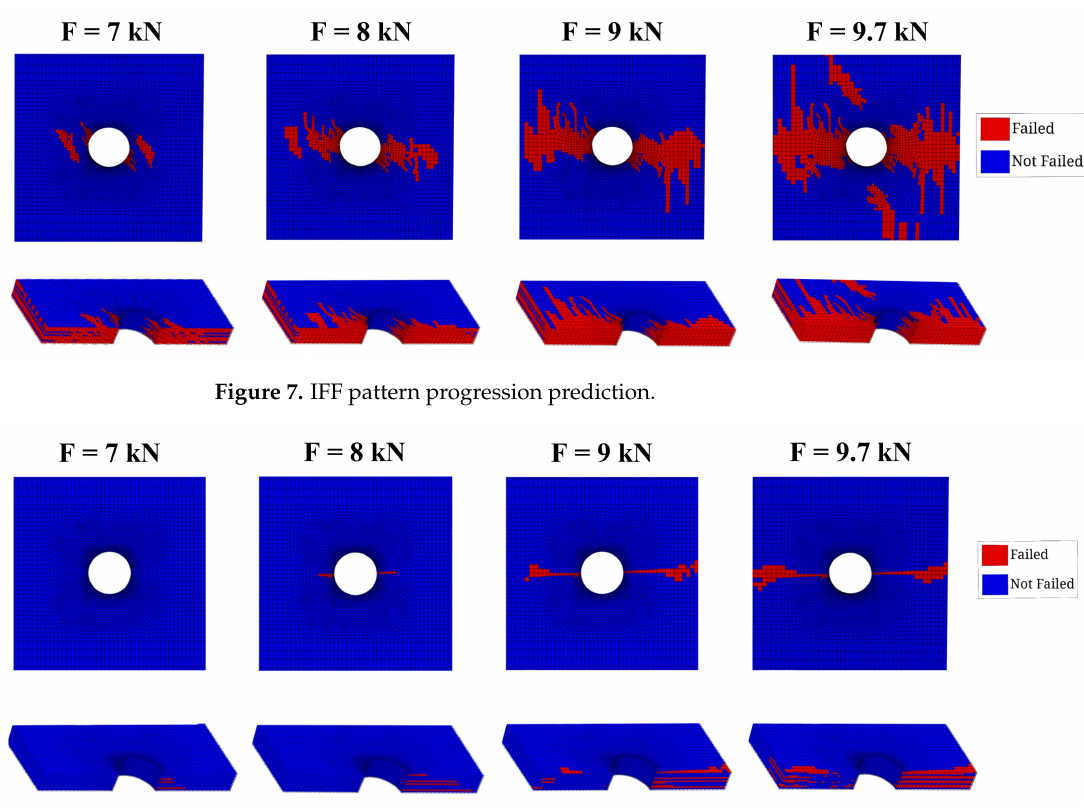
Figure 8. FF pattern progression